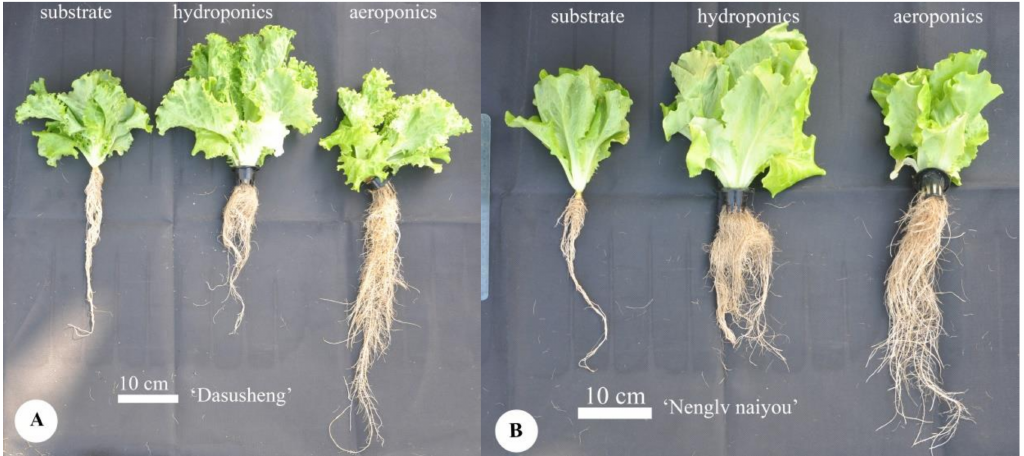
Figure 2. Whole plants of lettuce cultivars ‘Dasushen’ ( A ) and ‘Nenglv naiyou’ ( B ) 45 days after transplanting in aeroponic, hydroponic, and substrate cultivation